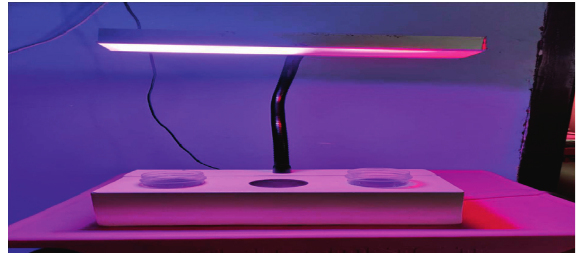
Figure 30: LED system with all the LEDs